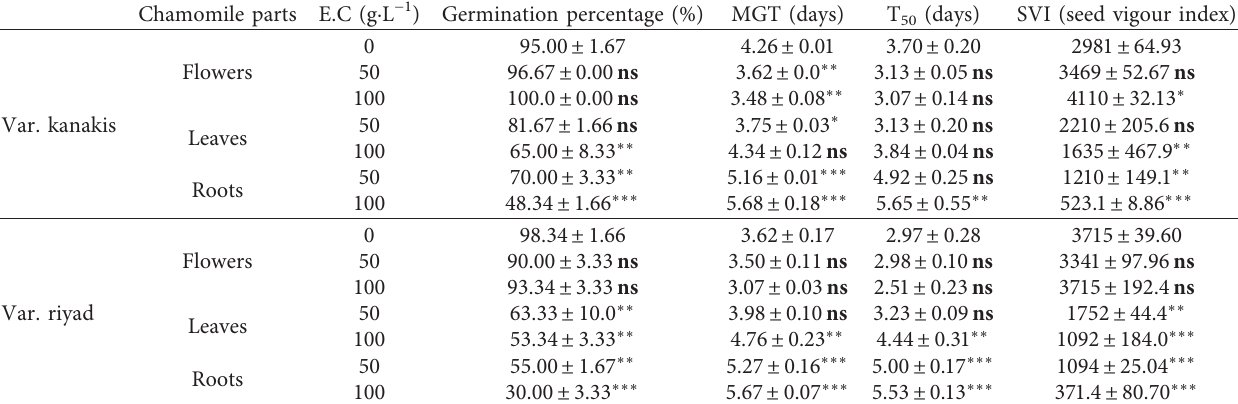
Table 1: Effects of Chamomile aqueous extracts on germination percentage (%), mean.